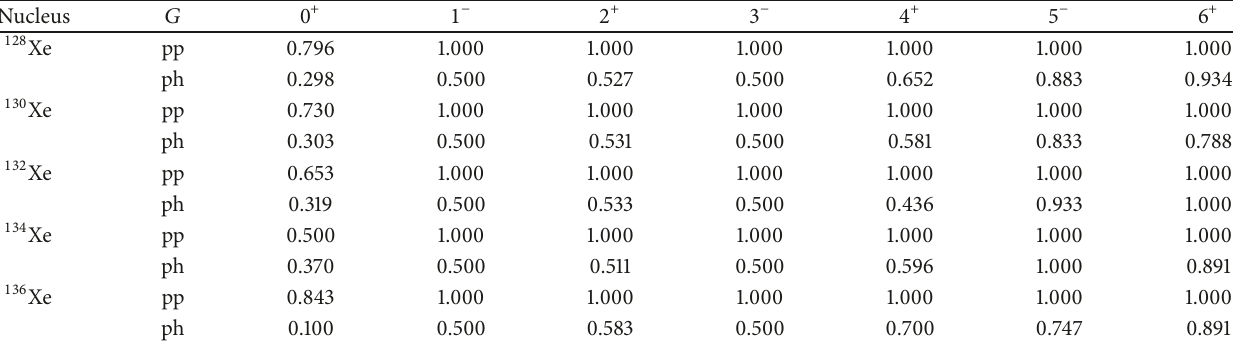
Table 1: Model parameters used in the BCS and QRPA calculations. For each nucleus (column 1) the values of 𝐺 given for the important 𝐽 휋 phonons in columns 3 to 9.